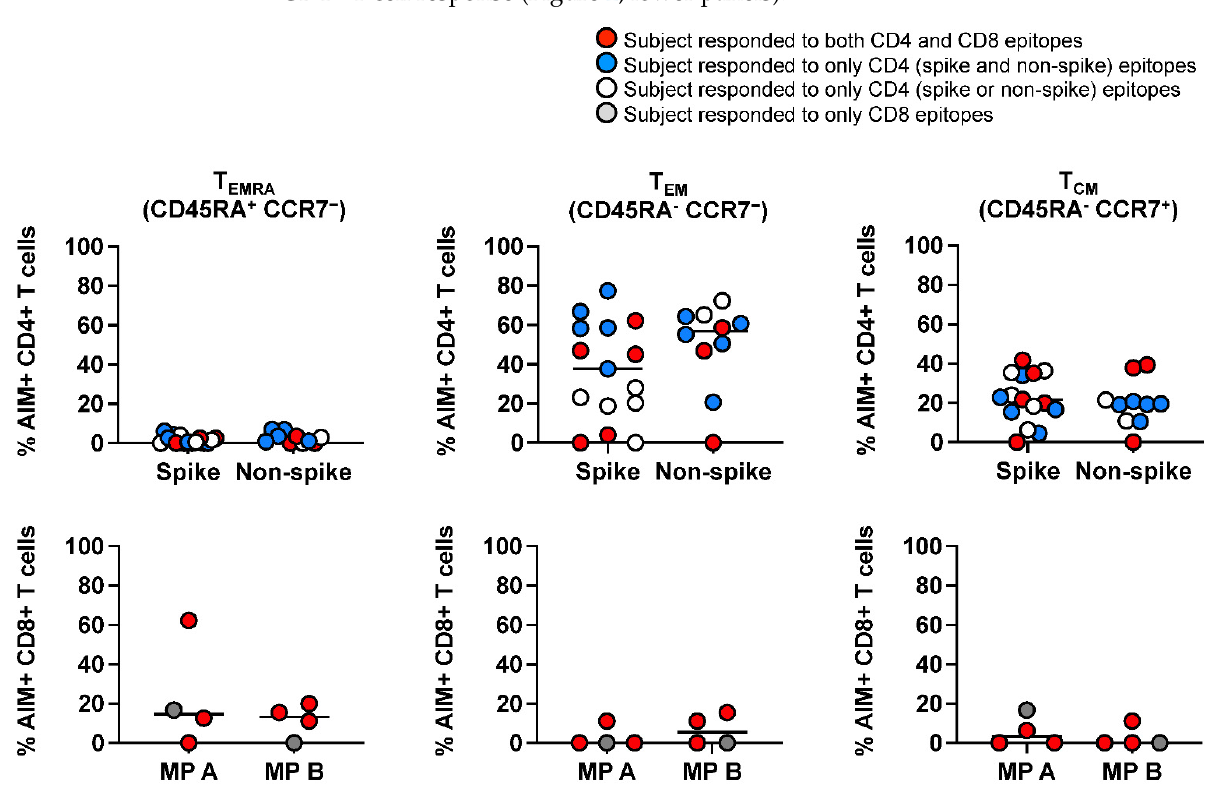
Figure 2. Memory phenotypes of SARS-CoV-2-specific, AIM+ CD4+, and CD8+ T cells in subacute MIS-C subjects. Memory phenotypes of SARS-CoV-2-specific AIM+ CD4+ (top panels) and CD8+ T cells (bottom panels) were studied 24 h after the peptide megapool stimulation. Each symbol shows the percentage of terminally differentiated effector T cells (TEMRA CD45RA+ CCR7 − ; left panels), effector memory T cells (TEM CD45RA − CCR7 − ; middle panels), and central memory T cells (TCM CD45RA − CCR7 − ; right panels) in the AIM+ CD4+ or CD8+ T cell populations. Red circles: subjects responding to both CD4 and CD8 epitopes (1, 2, 5, 18, and 19); blue circles: subjects responding to both CD4 spike and nonspike epitopes (3, 8, 9, 17, and 21); white circle: subject responding to either CD4 spike or nonspike epitopes (4, 10–12, 15, 20, and 22); gray circle: subject responding to only CD8 epitopes (7). Each symbol represents data derived from each individual subject. SARS-CoV-2-specific CD4+ T cells showed higher percentages of TEM and TCM phenotypes and lower percentages of TEMRA than SARS-CoV-2-specific CD8+ T